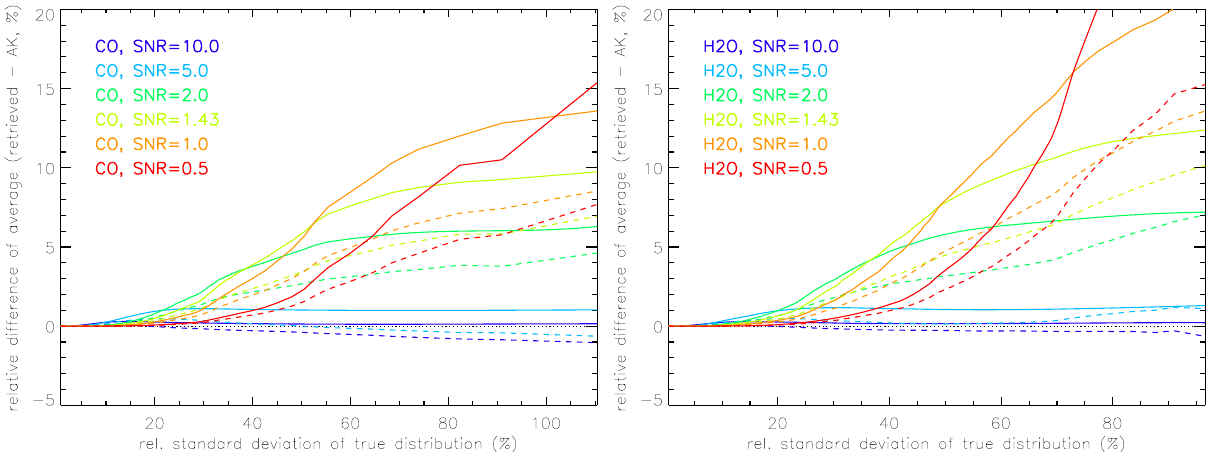
Fig. 7. Differences between the mean values and the mean “true” atmospheric state after application of the averaging kernel to the latter for CO (left) and H 2 O (right). Solid: linear averages, dashed: logarithmic averages. Results are shown for maximum a posteriori ln(vmr)-retrieval simulations with SNRs of 10 (dark blue), 5 (light blue), 2 (dark green), 1.43 (light green), 1.0 (orange), and 0.5